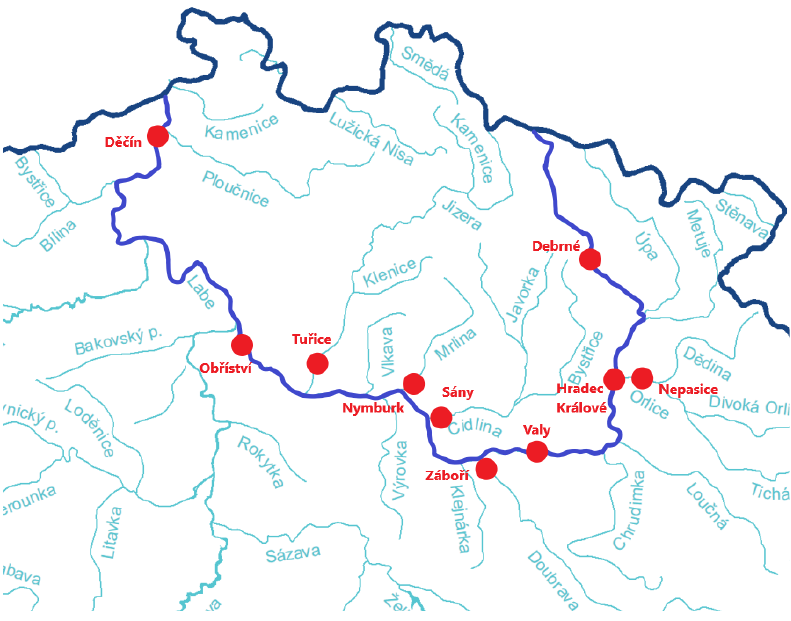
Figure 2. Map of sampling sites of the Elbe River basin.